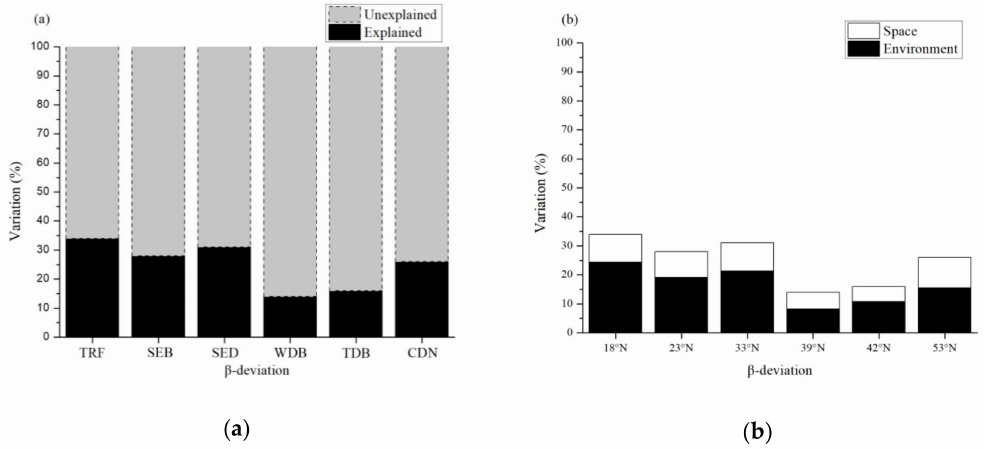
Figure 5. Soil fungal β -deviation explained by environmental and spatial variables in six forest types along a latitudinal gradient. ( a ) Total variation in β -deviation based on distance-based redundancy analysis. ( b ) Variation in β -deviations explained by environmental and spatial variables after forward model